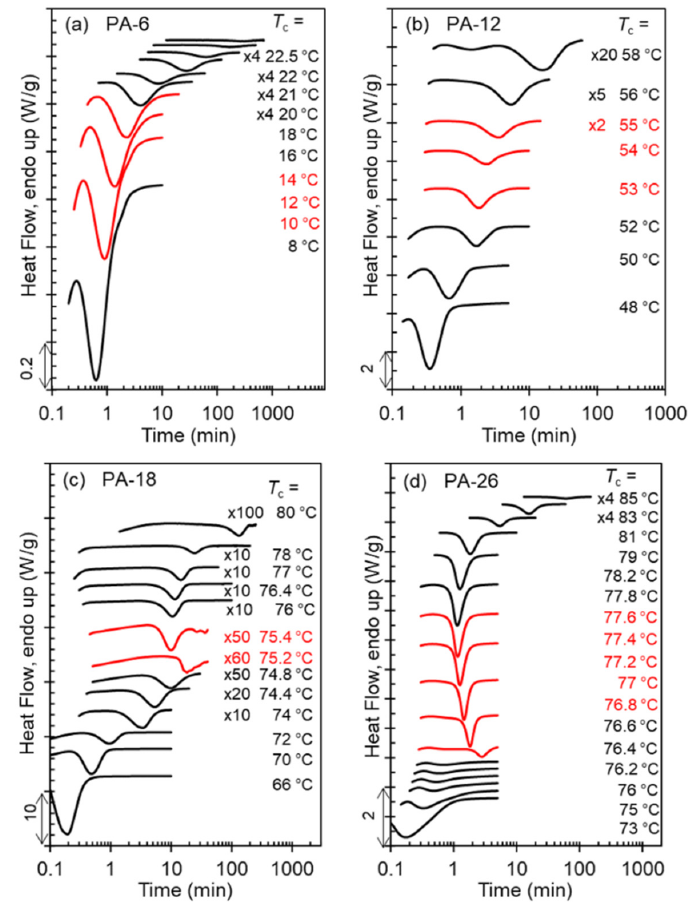
Figure 7. Crystallization exotherms collected as a function of time during isothermal crystallization at the indicated T c for ( a ) PA-6, ( b ) PA-12, ( c ) PA-18, and ( d ) PA-26. Data have been vertically shifted for clarity. For PA-18 and PA-26, red thermograms indicate the transition between Form I and Form II. For PA-6 and PA-12 the red thermograms infer transition from hexagonal to Form I. Where indicated, data were multiplied by the constant factors shown to better display small heat flow.